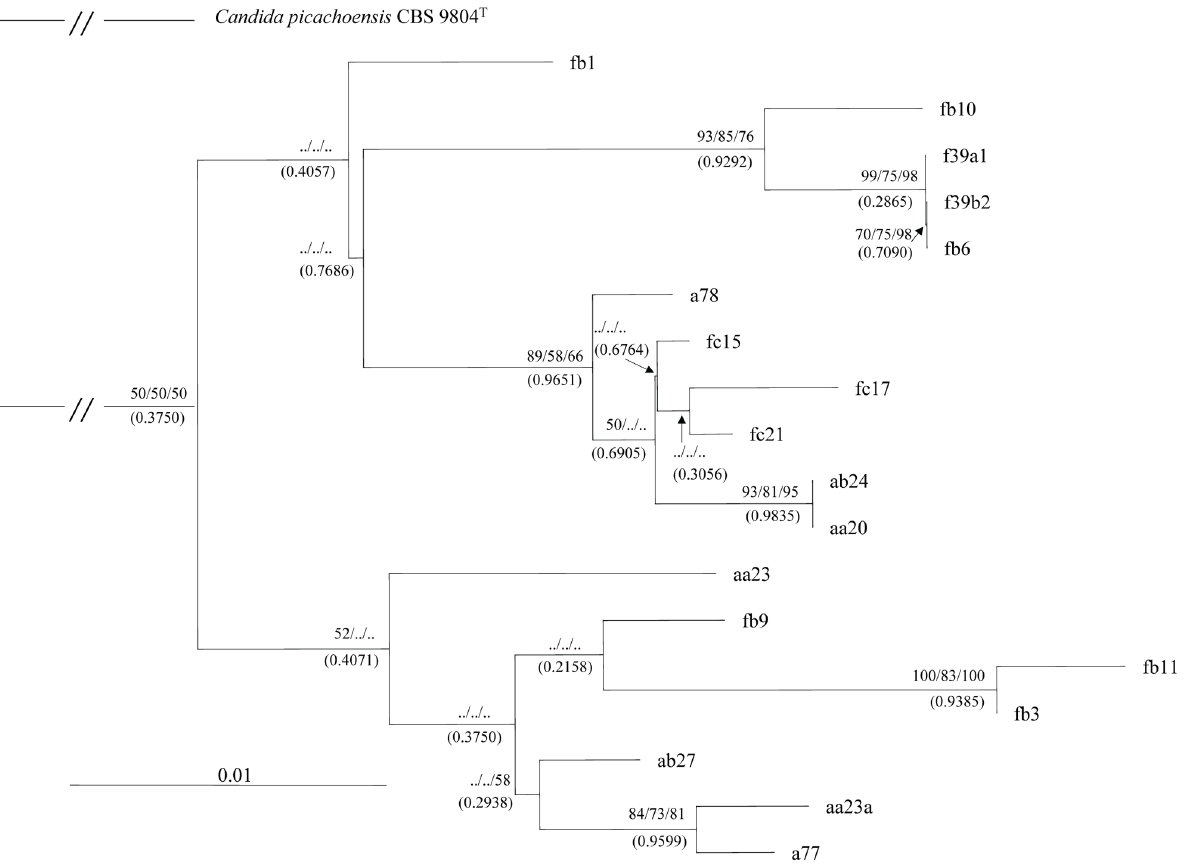
Figure 4. A phylogenetic tree derived from the neighbor-joining analysis of the cloned D1/D2 sequences. Neighbor-joining bootstrap values (before the first slash), maximum-parsimony bootstrap values (between slashes) and maximum-likelihood values (after the second slash) $ 50% are given at branch nodes. Numbers in brackets are Bayasian posterior probabilities. Outgroup: Candida picachoensis . GeneBank accession numbers of the sequences are listed in Table 1. Bar, 0.01 substitutions per nucleotide position.